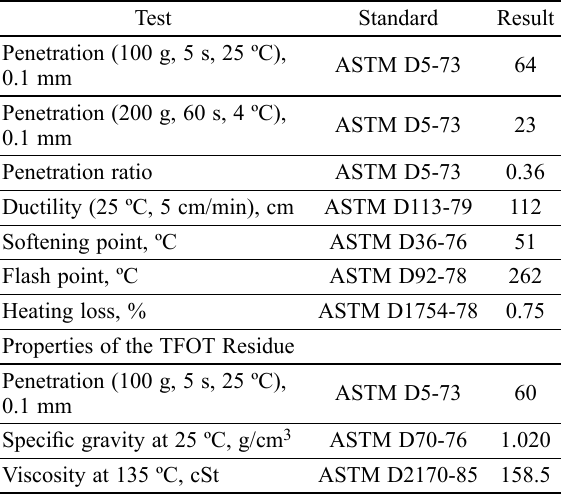
Table 3. Experimental results of 60–70 penetration asphalt binder Test